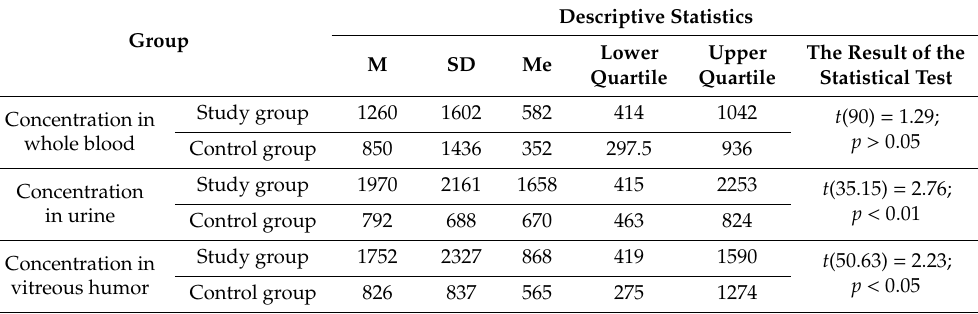
Table 8. Descriptive statistics for 1,5-anhydroglucitol determinations in the study and control groups.